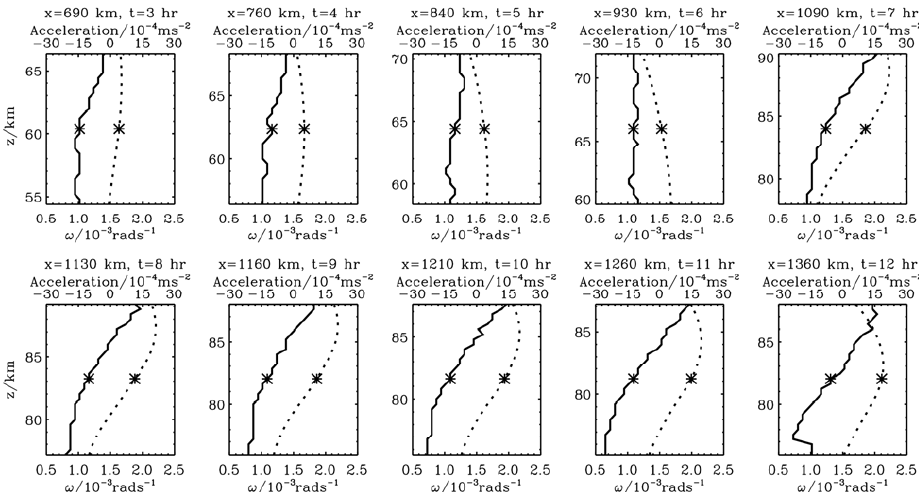
Fig. 3. Height and time variations of the ground-based GW frequency (solid curves) and the tidal horizontal-wind acceleration (dotted